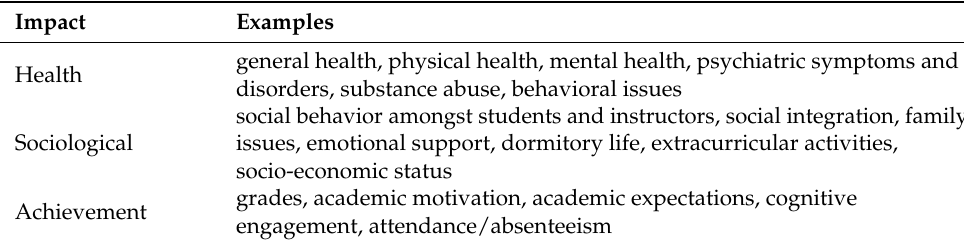
Table 1. Types of Academic impacts and examples.